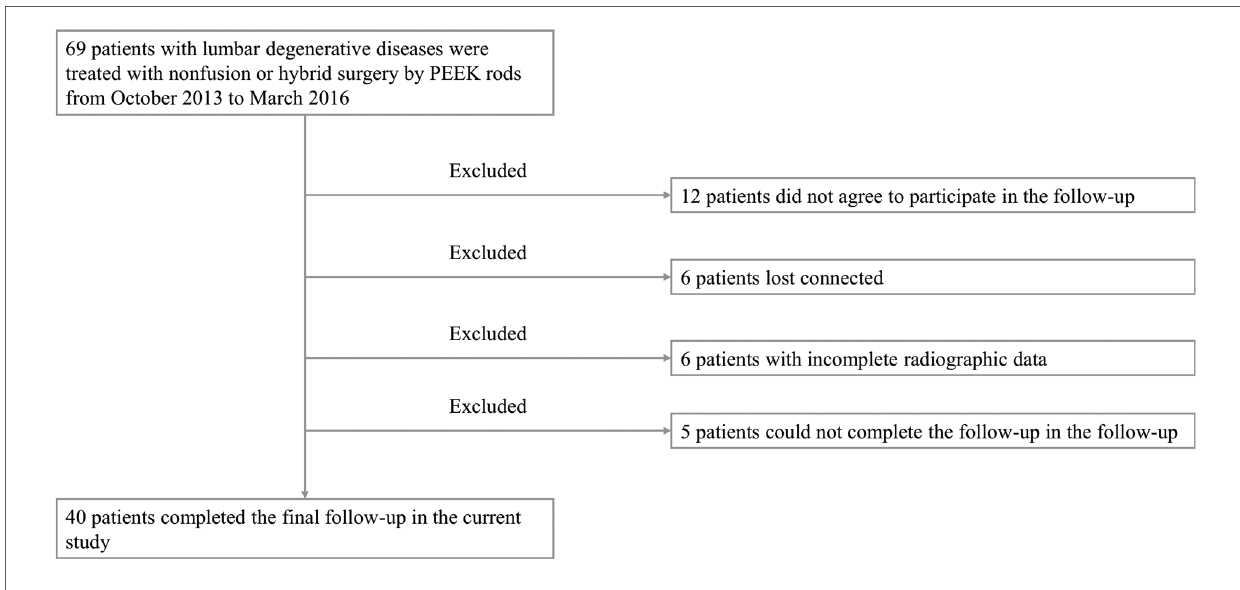
FIGURE 2 Flow chart of patient selection